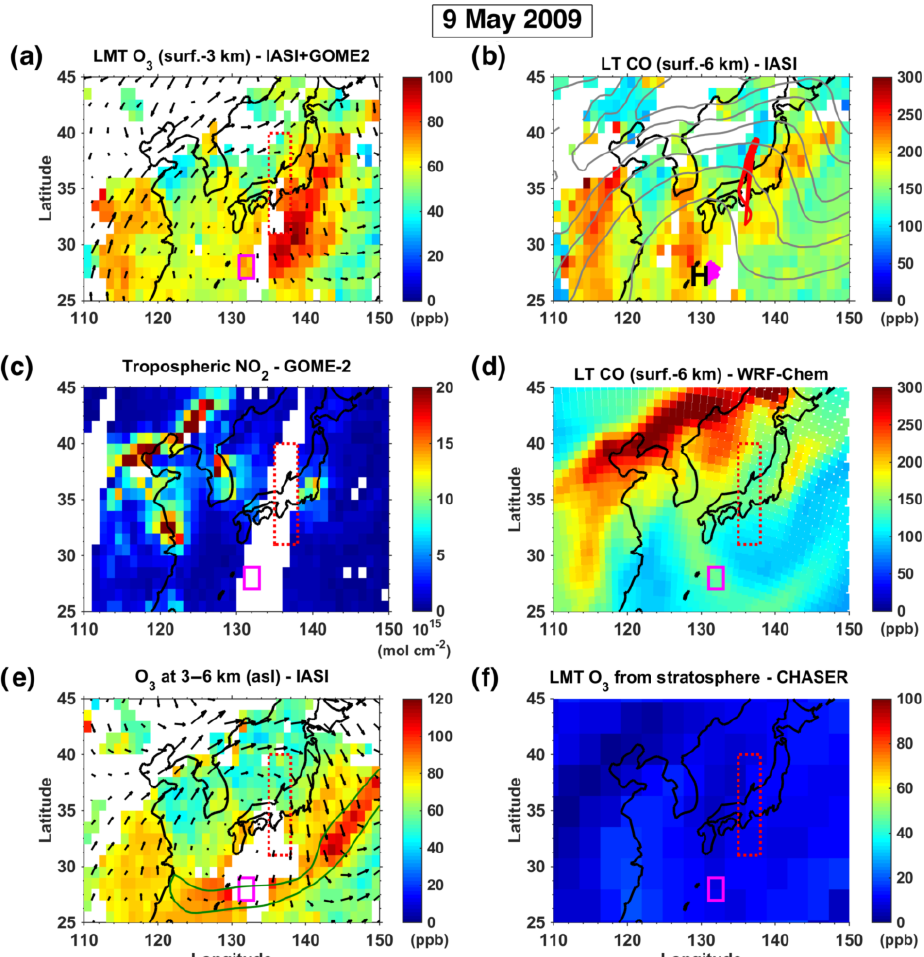
Figure 12. Same as Fig. 10 but for 9 May 2009. Here, no shift is considered for the location of the northern pollution plume (dotted red square) in WRF-Chem simulations, with respect to that of satellite